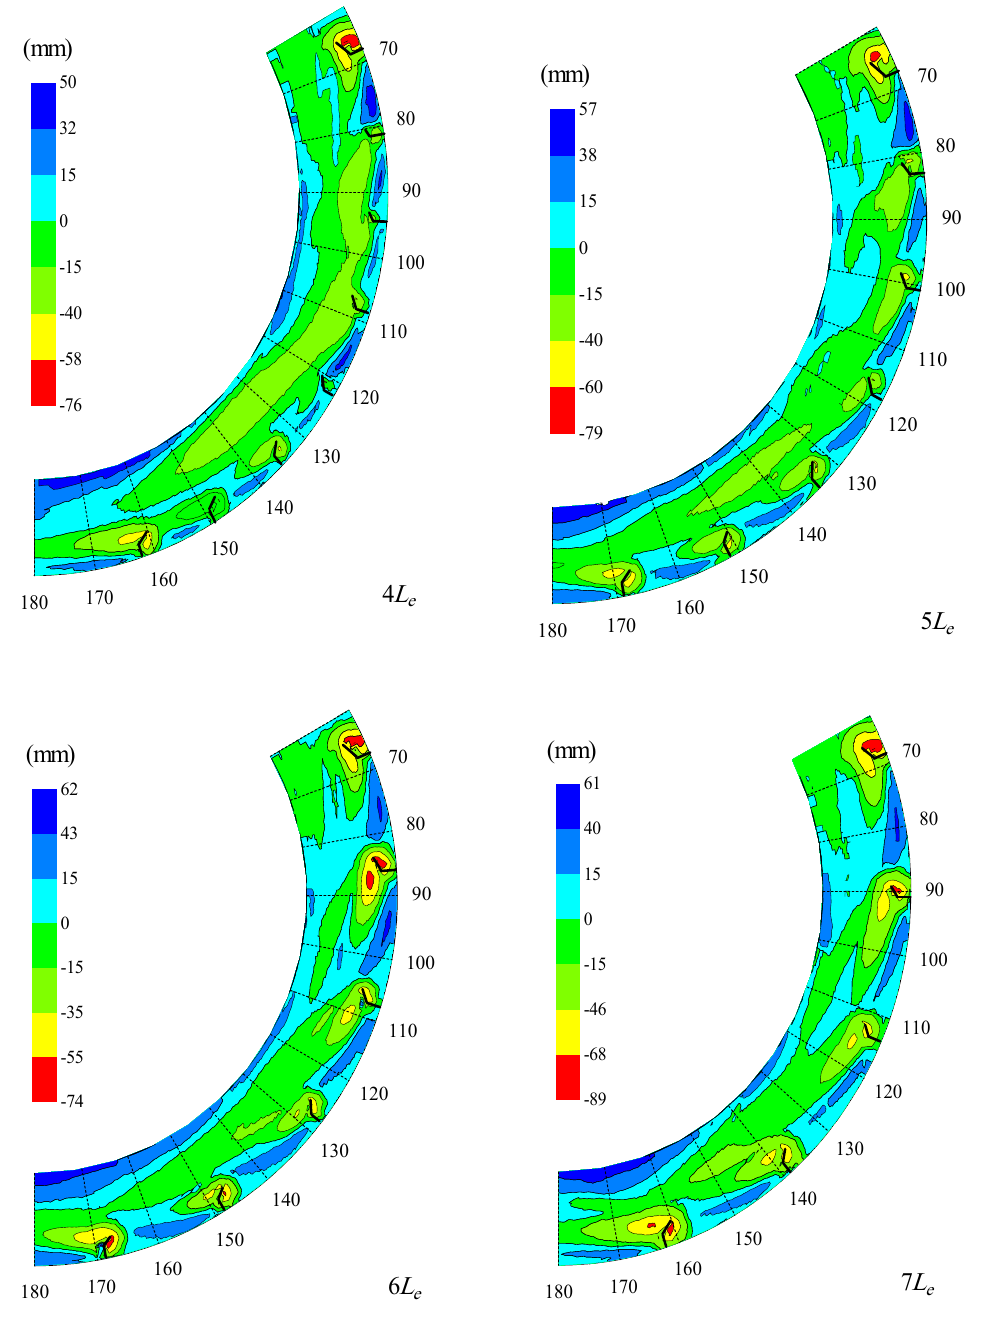
Figure 6. Bed topography variations for different distances ( A 50 = 2.55).